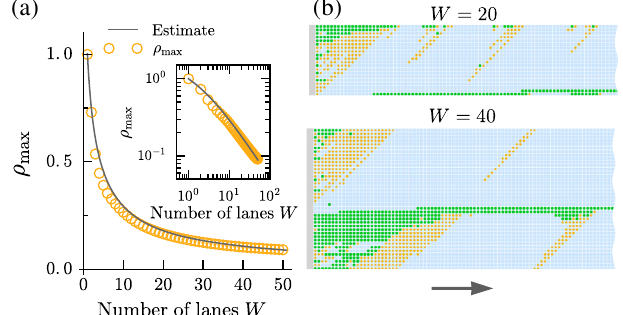
FIG. 4. Dependence of the maximal density ρ on the number max of lanes W for the special case δ ¼ 1 = 2 and L ¼ 16384 . (a) Rapidly decreasing ρ with increasing numbers of lanes max W . The decrease can be estimated by a maximum entropy W Þ ≈ Hm ð W Þ =W (solid line). (b) Snap- argument leading to ρ max ð shots of particle distributions in systems with W ¼ 20 and W ¼ 40 to illustrate the maximal density. Although the system is almost fully occupied at the left lattice end, the degree of occupation successively decreases and converges to the maximal density. Larger numbers of lanes exhibit more inaccessible sites and therefore a lower maximal density. In panel (b), the same symbols as in Fig. 1 are used to plot the system and particles. Only the leftmost part of the system is shown for illustrative